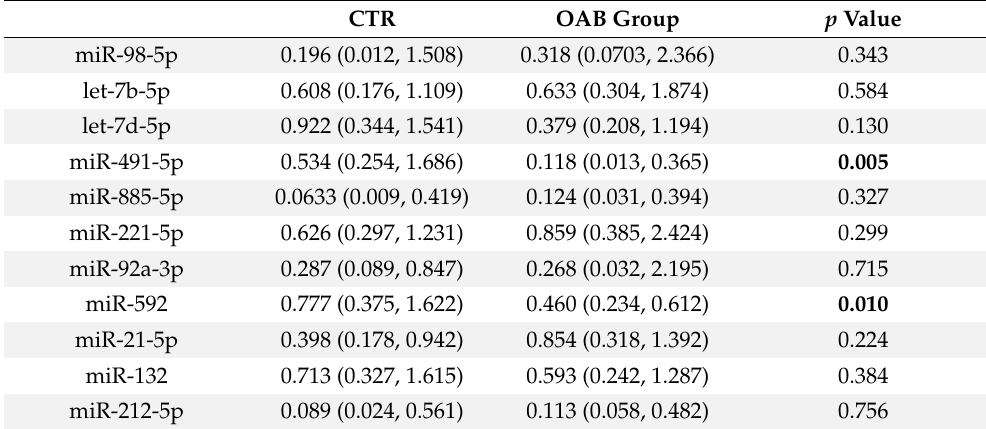
Table 2. miRNA expression (2 − ∆∆ CT ) between the control (CTR) and OAB groups without consider- ing confounders. CTR